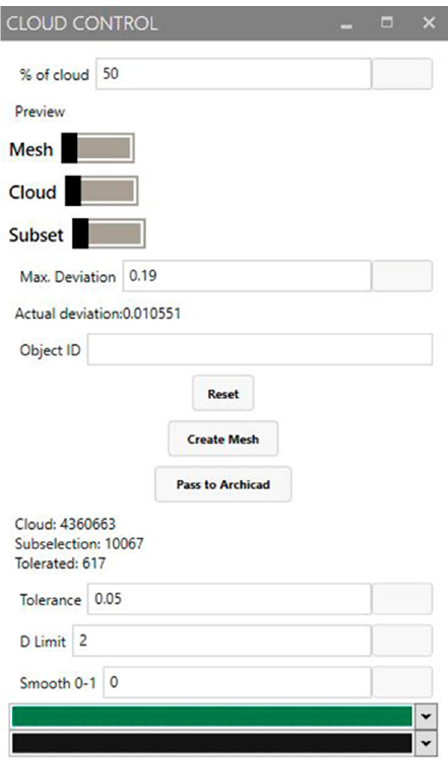
Figure 13. Interface. Figure 13.